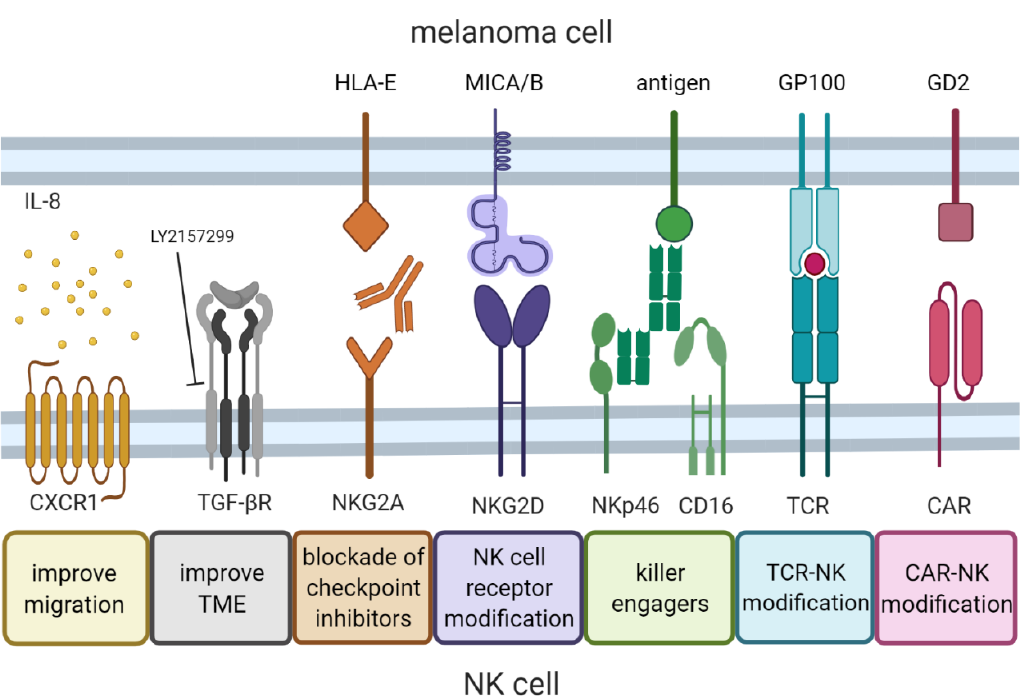
Figure 2. Strategies to improve NK cell therapy for melanoma. Different approaches can be implemented to improve NK cell therapy for melanoma. NK cells can be redirected to the tumor site by increasing migration via upregulation of chemokine receptor CXCR1. At tumor site, the immunosuppressive effect of the TME can be neutralized by inhibitors targeting immunosuppressive factors, such as TGF- β . Cytotoxicity can be improved by combination therapy, such as blocking checkpoint inhibitors (i.e., NKG2A) or using killer engagers such as bi/tri-specific antibodies. Another approach to improve cytotoxicity utilizes genetic modification of NK cells to overexpress activating receptors such as NKG2D, or arming NK cells with TCRs or CARs targeting tumor-associated antigens such as GP100 or GD2.